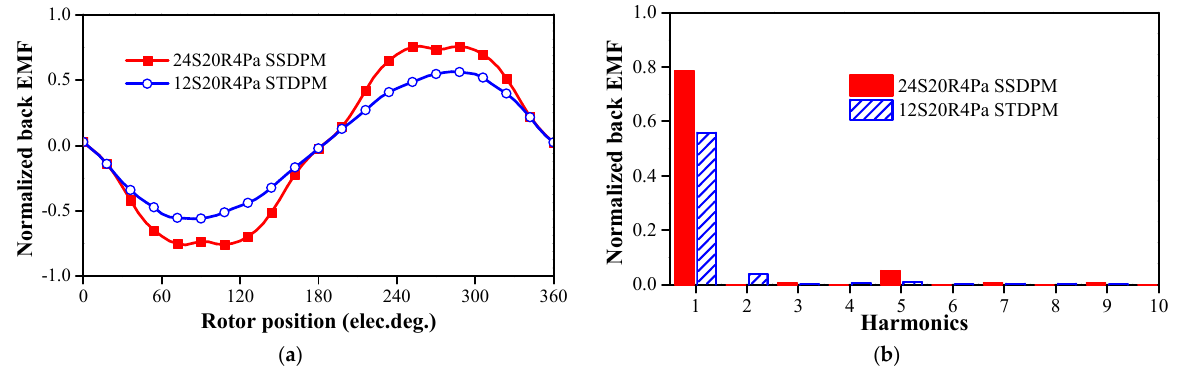
Rotor position (elec.deg.) Rotor position (elec.deg.) Figure 20. Back EMFs of two dual-PM machines at 600 rpm. ( a ) Waveforms; ( b ) spectra. Figure 20. Back EMFs of two dual-PM machines at 600 rpm. ( a ) Waveforms; ( b ) spectra. Figure 20. Back EMFs of two dual-PM machines at 600 rpm. ( a ) Waveforms; ( b )